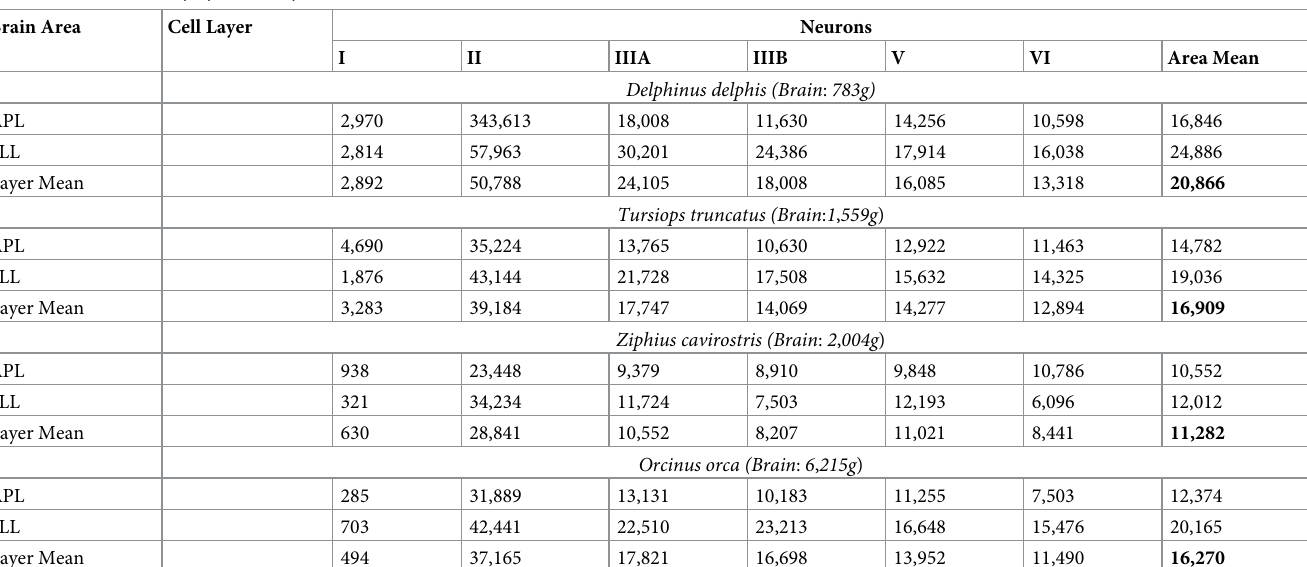
Table 2. Neuron density by cortex layer.